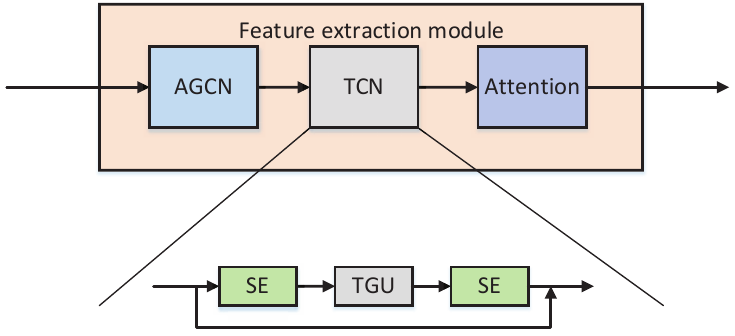
Figure 5. Feature extraction module.